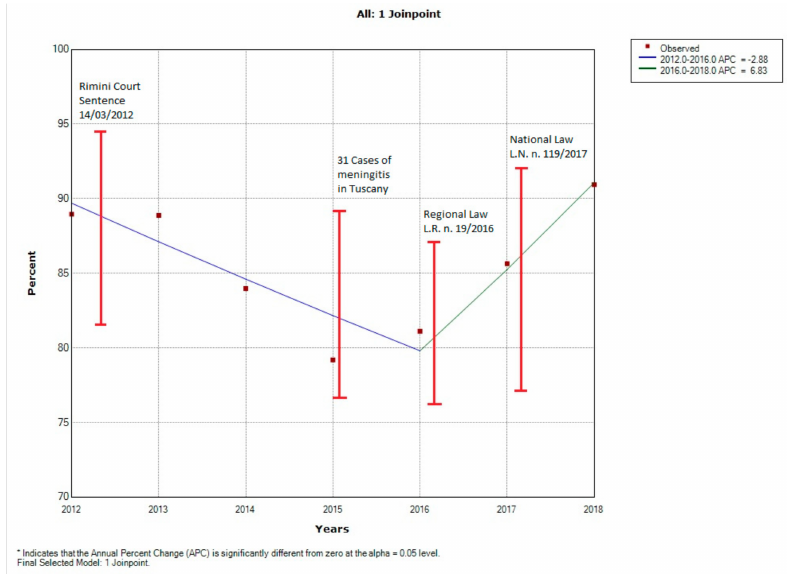
Figure 2. Trend of 24-month vaccination rates per 100,000 inhabitants between 2009 and 2018 in the Sicily region. Table 5. Percentage of vaccinated and unvaccinated children in the Sicily region in 2012 and comparisons with the following